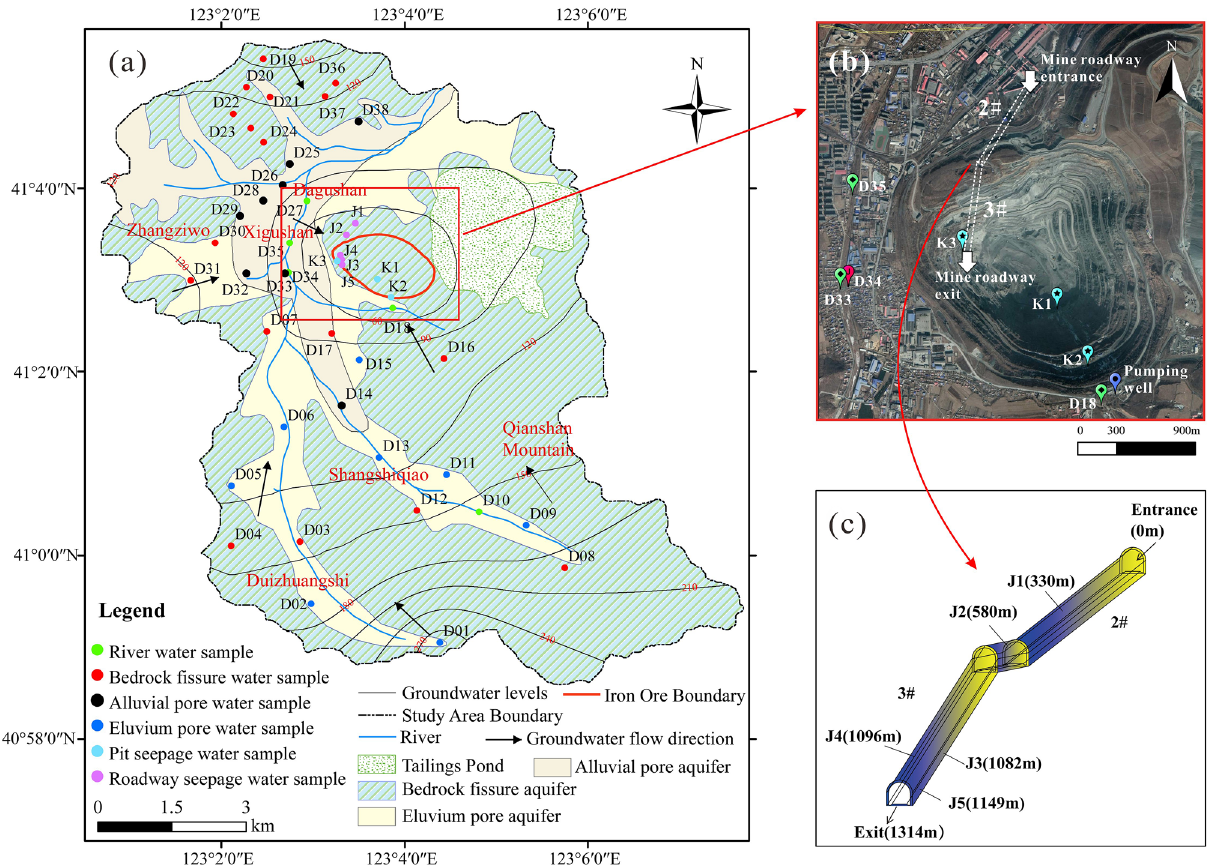
Figure 2. (a) Hydrogeological map of the study area and sampling points (the map was generated using ArcGIS 10.2, https:// www. esri. com). (b) Satellite image illustration of water seepage points in the open-pit. (c) Schematic diagram of water seepage points in the